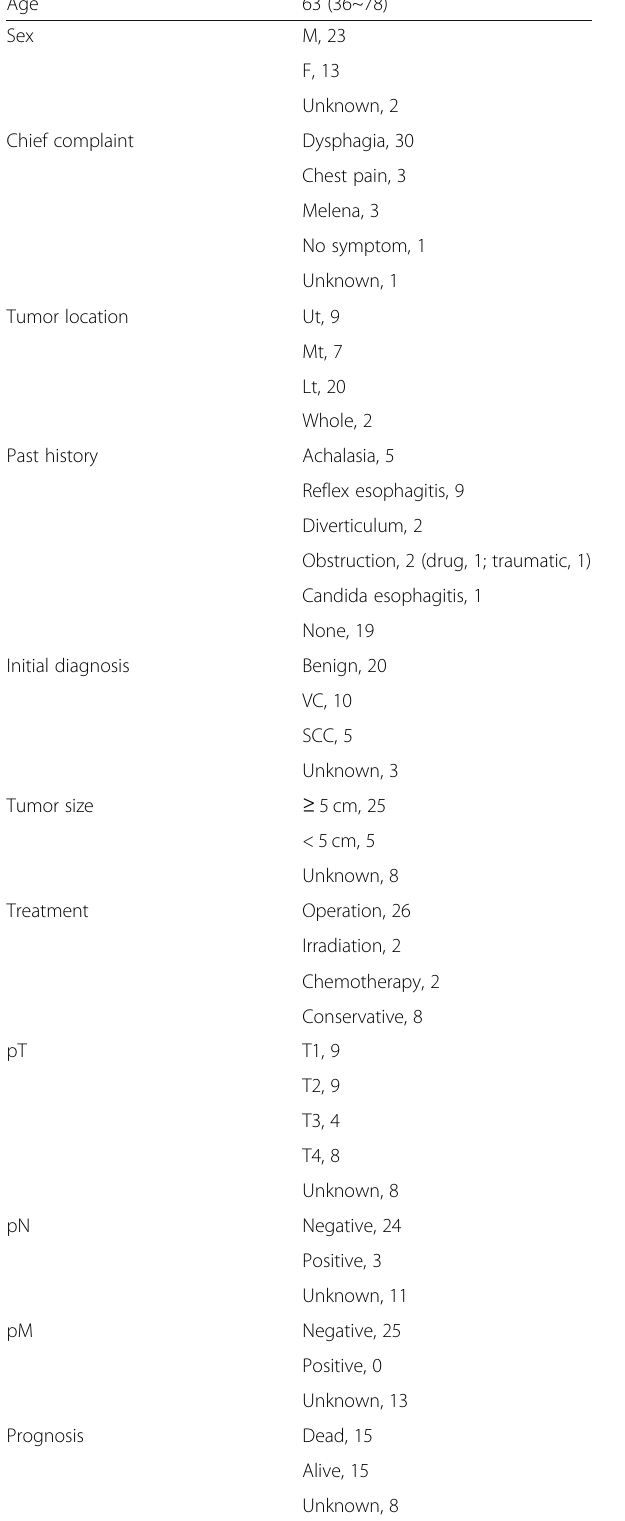
Table 1 Clinical characteristics of verrucous carcinoma of the